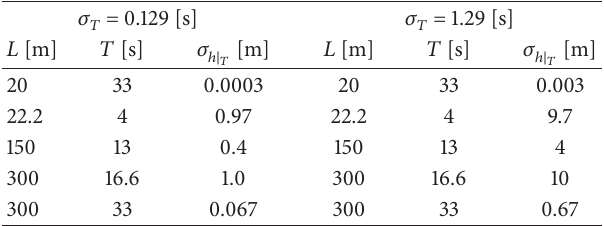
Table 2: Values of uncertainty in the estimated water depth due to , for different ( 𝐿,𝑇 ) and 𝜎 𝑇 that in swell period, 𝜎 ℎ| 𝑇